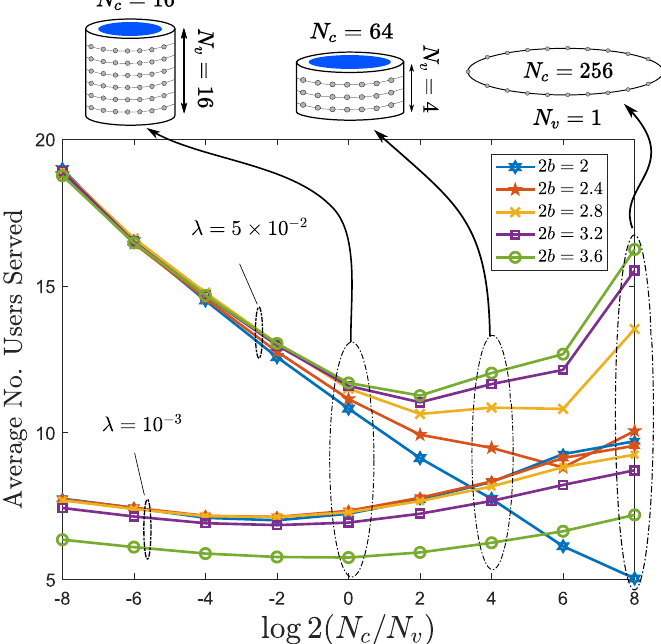
( N c / N v ) , within ¯ R = 100m while 2